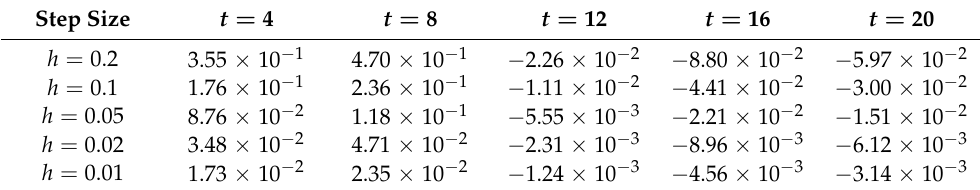
Figure 3. The time domain response of IFOTF (2). Table 4. Difference between the results of the two